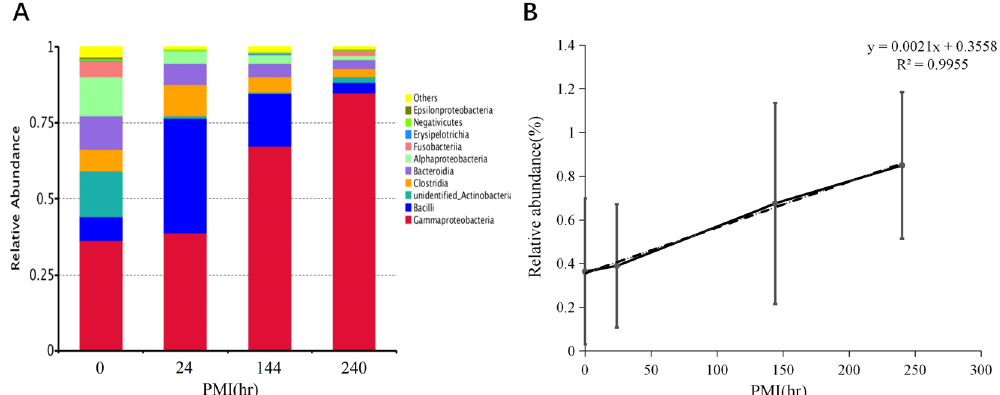
Figure 3. ( A ) Relative abundance of classes of bacteria with different PMI. ( B ) Relative abundance changes of Gamma-proteobacteria had positive strong linear relationship with PMI.